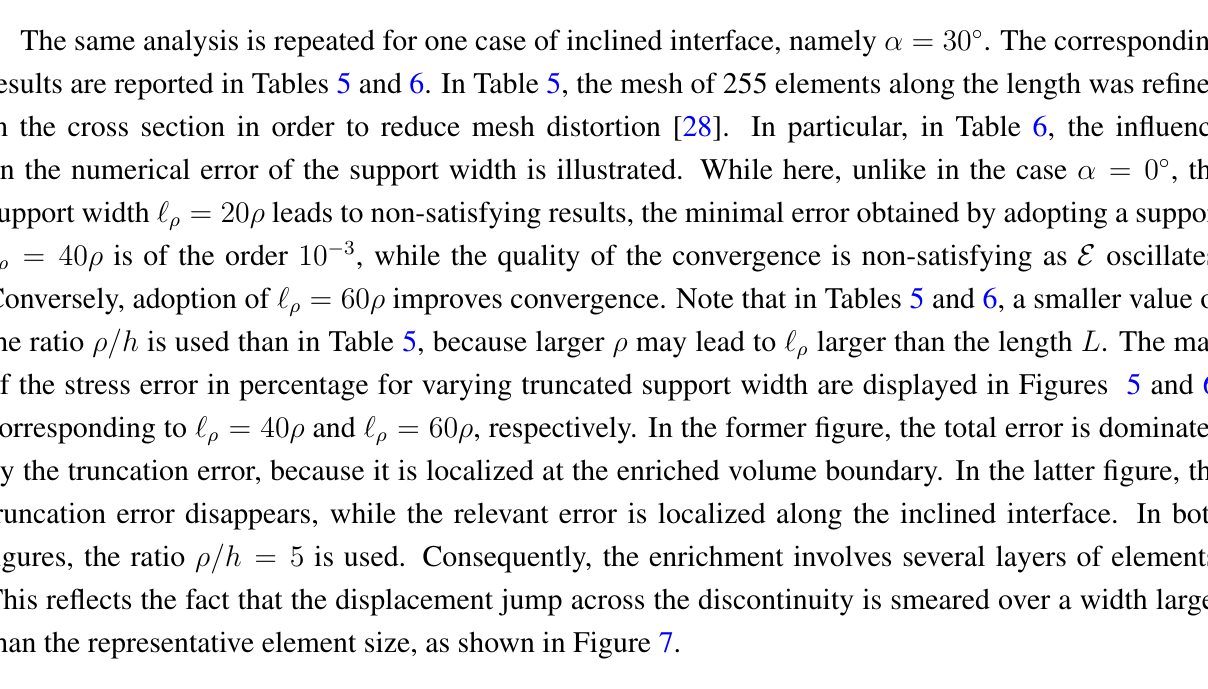
Table 5. Error for decreasing h , fixed ρ = L/ 100 , α = 30 ◦ , support width ℓ